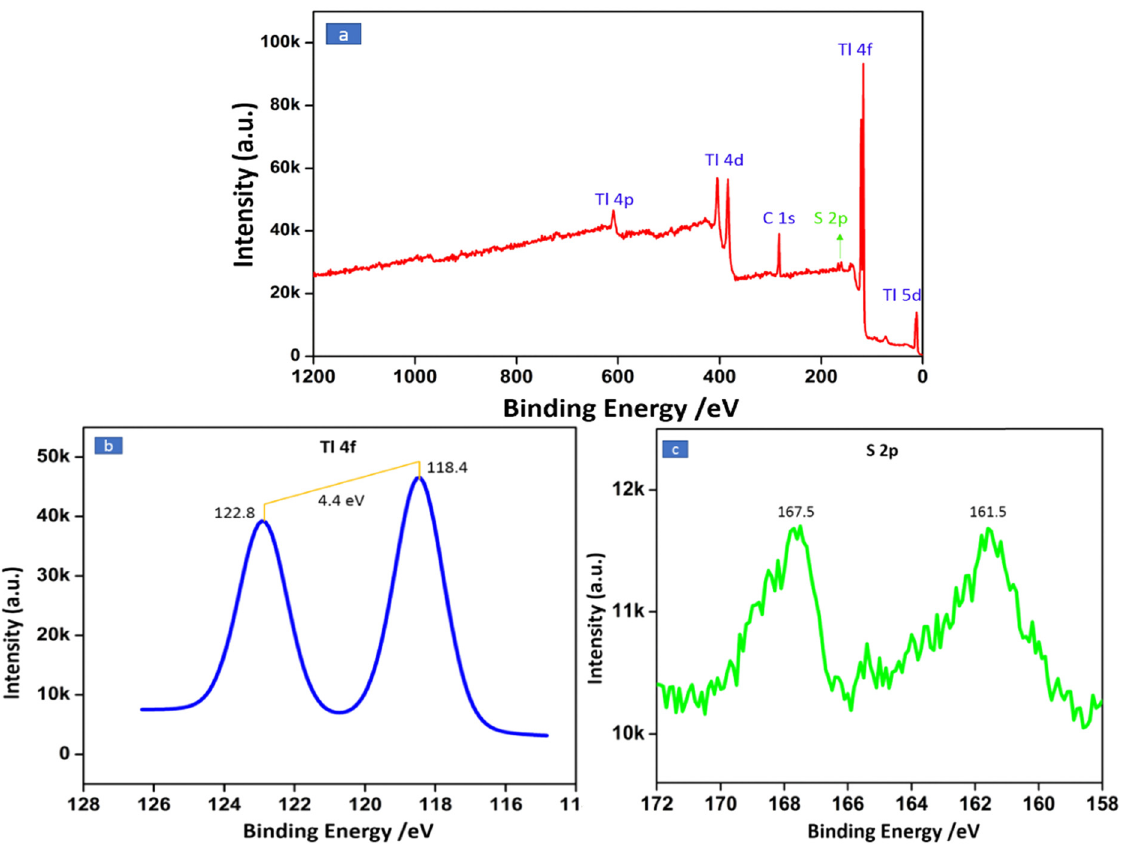
Figure 3: XPS results of Tl 2 S thin fi lms fabricated at 600°C using THF solution of complex 1 via AACVD approach: ( a ) survey scan, ( b ) Tl 4f, and ( c ) S 2p.